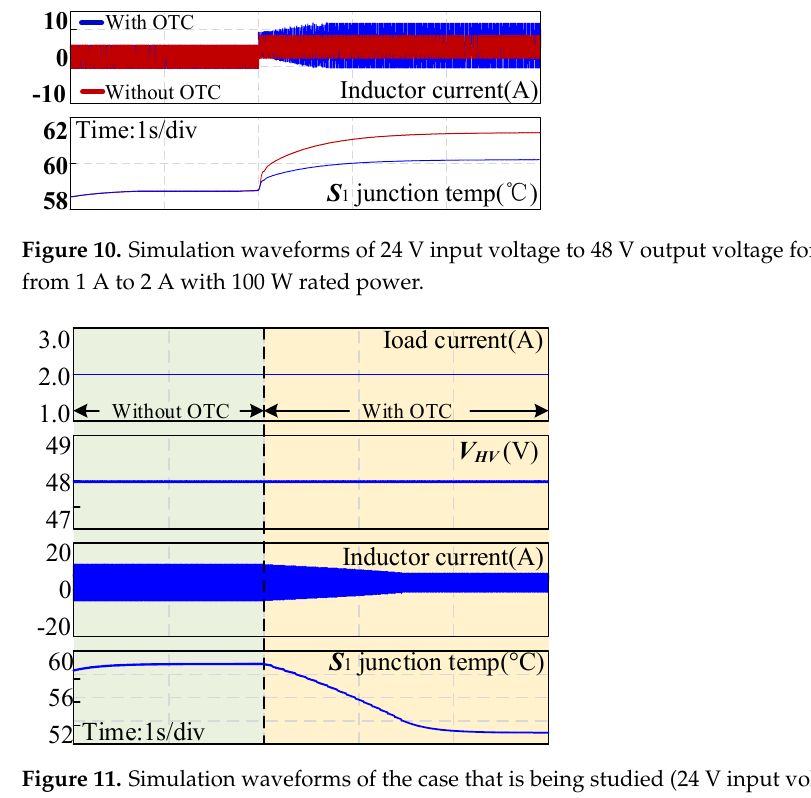
Figure 11. Simulation waveforms of the case that is being studied (24 V input voltage to 48 V output voltage with full load 100 W for fixed switching frequency convert to adaptive switching frequency).